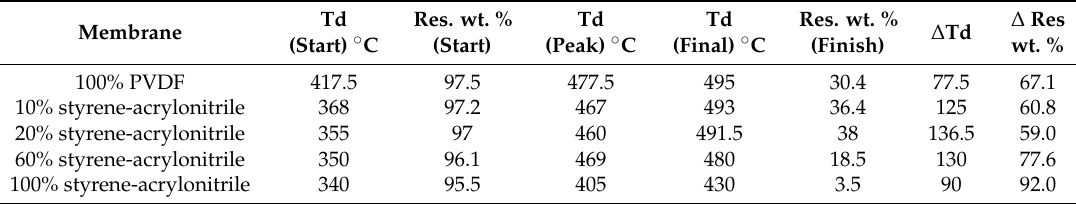
Table 4. Degradation temperatures of PVDF blend